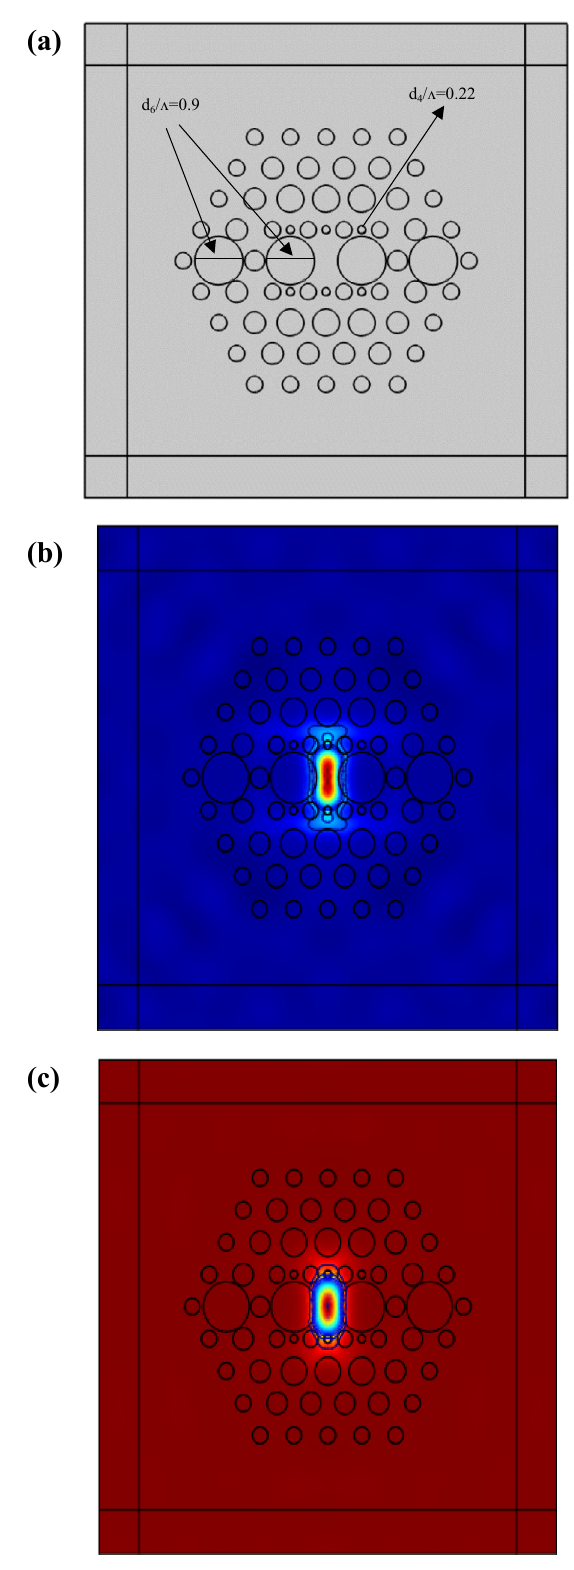
Fig. 3 (See legend on previous